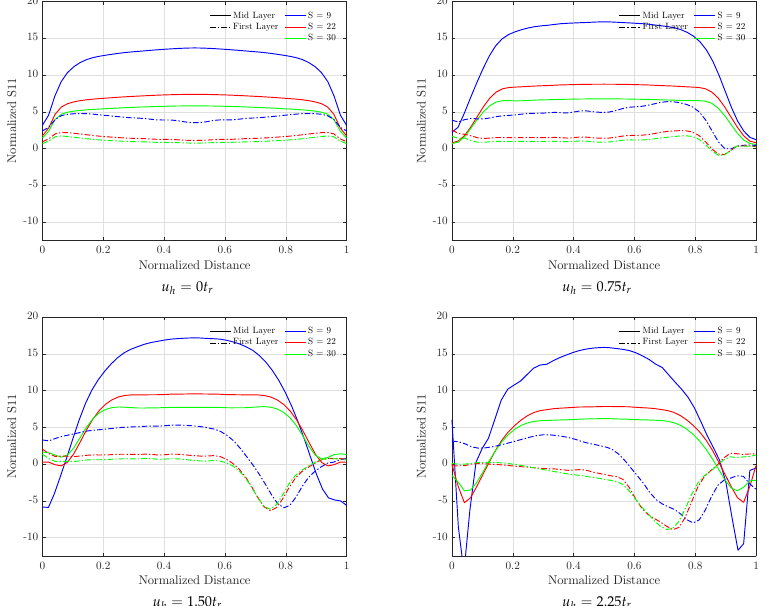
Figure 11. Axial stress S11 on the reinforcement along the symmetry axis. Effect of shape factor S